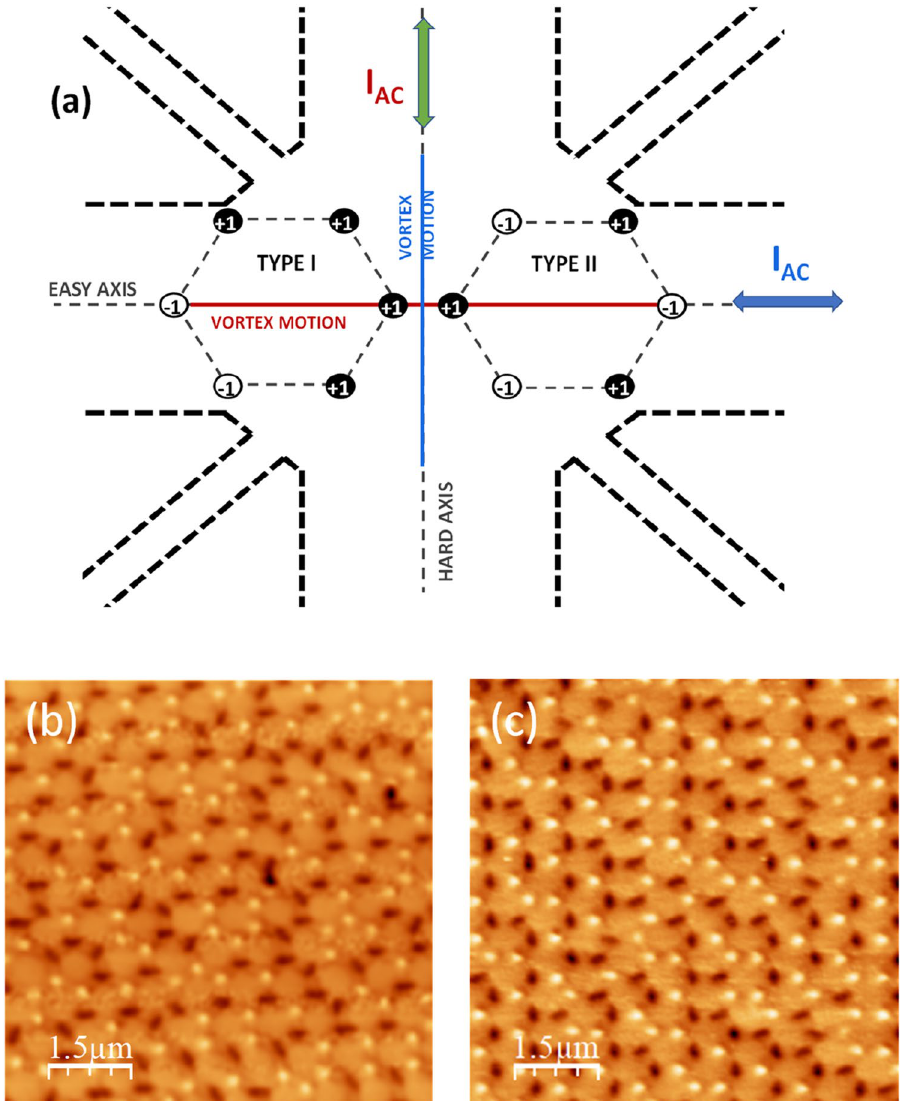
Figure 1. ( a ) Experimental configuration sketch. Including cross-shaped bridge (see "Methods") and the typical spin ice configurations in the honeycomb array (in this work only type I is studied). Colors red and blue identify the two directions of motion for superconducting vortices, which are perpendicular to the AC driving current (double-headed arrows). Black and white dots represent magnetic charges from the spin ice providing the asymmetric landscape that yields ratchet effect. ( b ) Experimental MFM image of as-grown sample (sample A) and ( c ) Experimental MFM image of remanent state magnetic selection protocol sample (sample B); see text